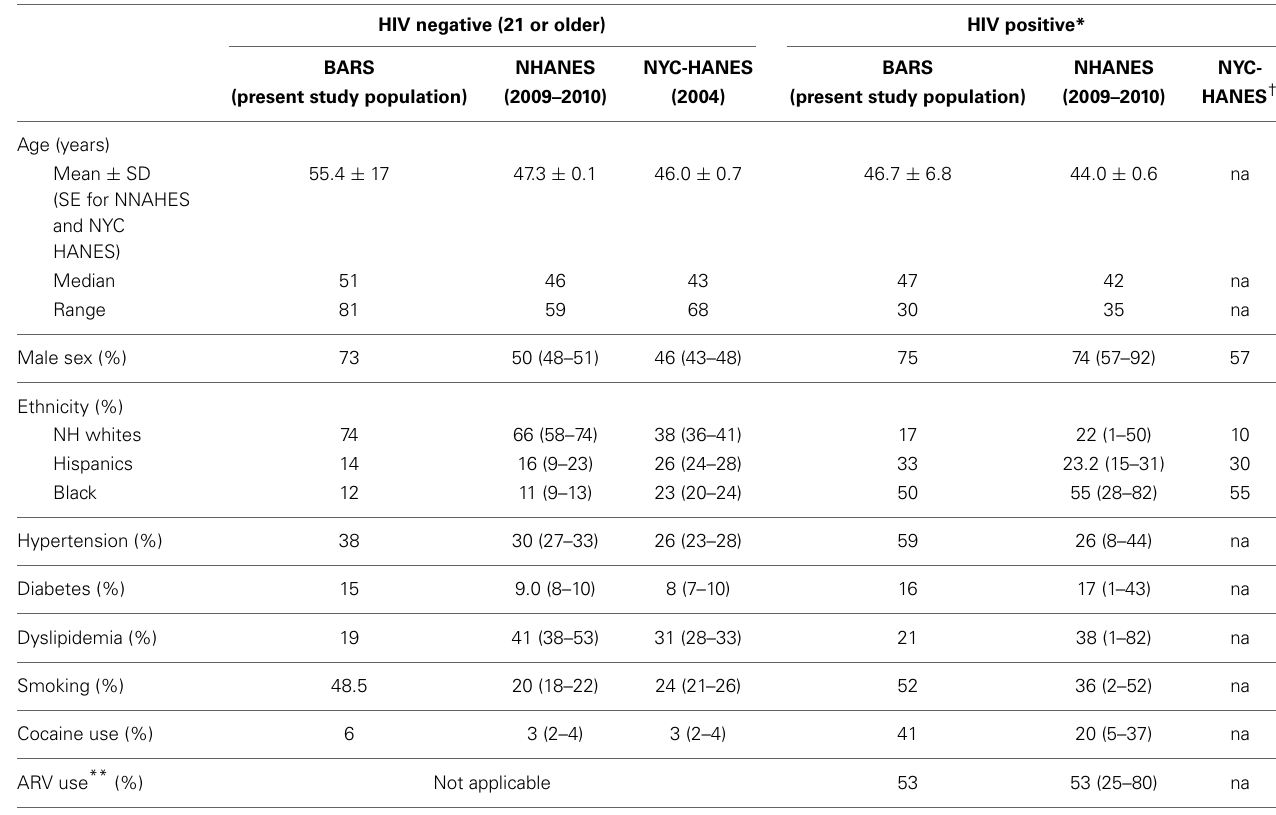
Table 5 | Cardiovascular profile of the studied sample compared to the US and NY populations. HIV negative (21 or